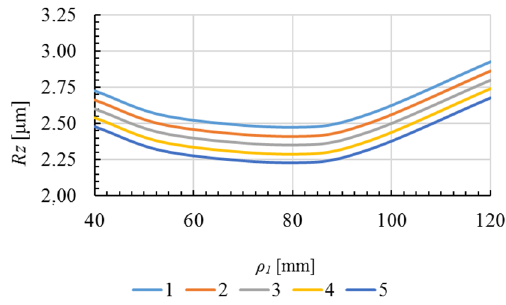
Figure 18. Effect of the curvature radius ρ 1 on the Rz roughness parameter in the machining of the concave surface: (1) α = 7°, (2) α = 11°, (3) α = 15°, (4) α = 19°, (5) α = 23°.